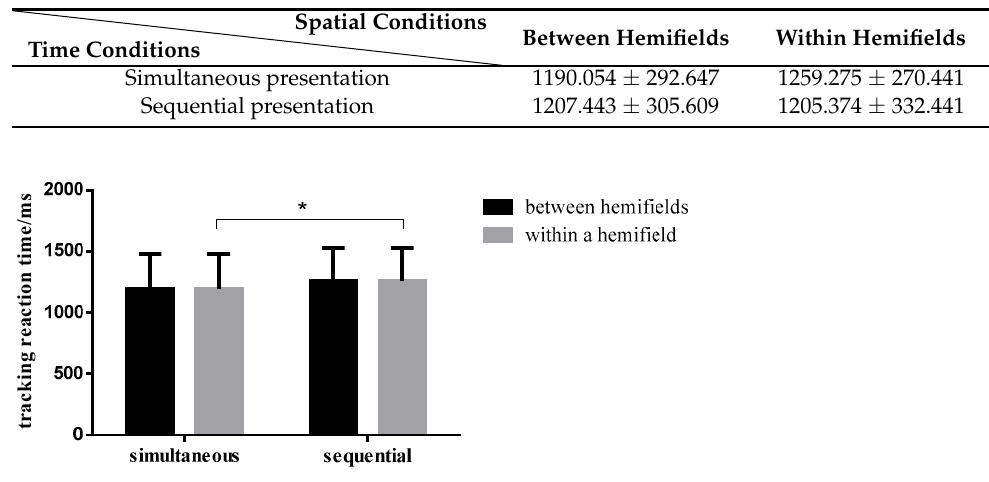
Table 2. Tracking reaction time t/ms (M ± SD, N = 33).